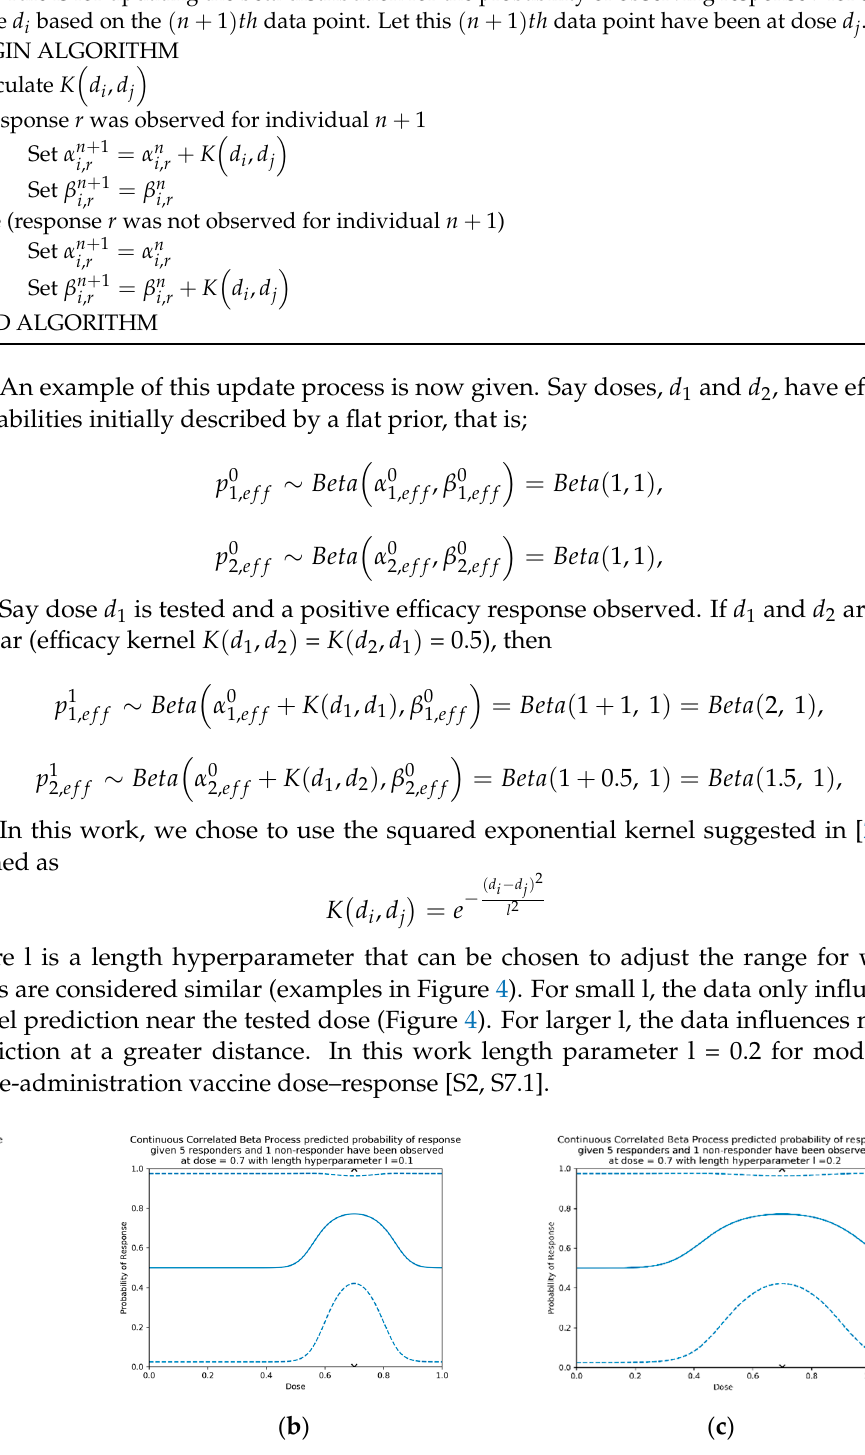
Figure 4. An example of three different CCBP models with squared exponential kernels for different length hyperparameters, using the flat prior for all doses, and 6 observed responses at dose = 0.7 (5 responders, 1 non-responder, as per Figure 1h). Length parameters are ( a ) 0.02, ( b ) 0.1 and ( c ) 0.2. The solid line is the median predicted probability, and the dashed lines show the 95% confidence interval.